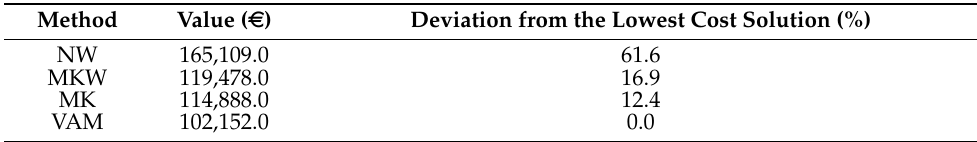
Table 9. Objective function and deviation from lowest cost